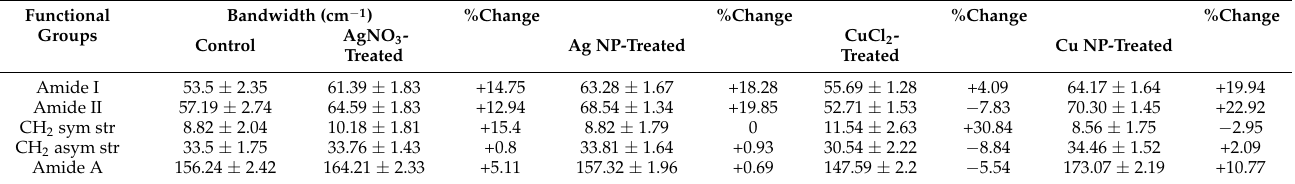
Figure 9. Selected regions (2450–3700 cm − 1 ) of FT − IR spectra of S. aureus before and after treatment with ( a ) AgNO 3 , ( b ) CuCl 2 , ( c ) Ag NPs, and ( d ) Cu NPs solutions with different concentrations. Table 2. Differences in bandwidths of peaks between control and treated bacteria. Table 1. IR band assignments of bacteria (treated with antibacterial agents and control).